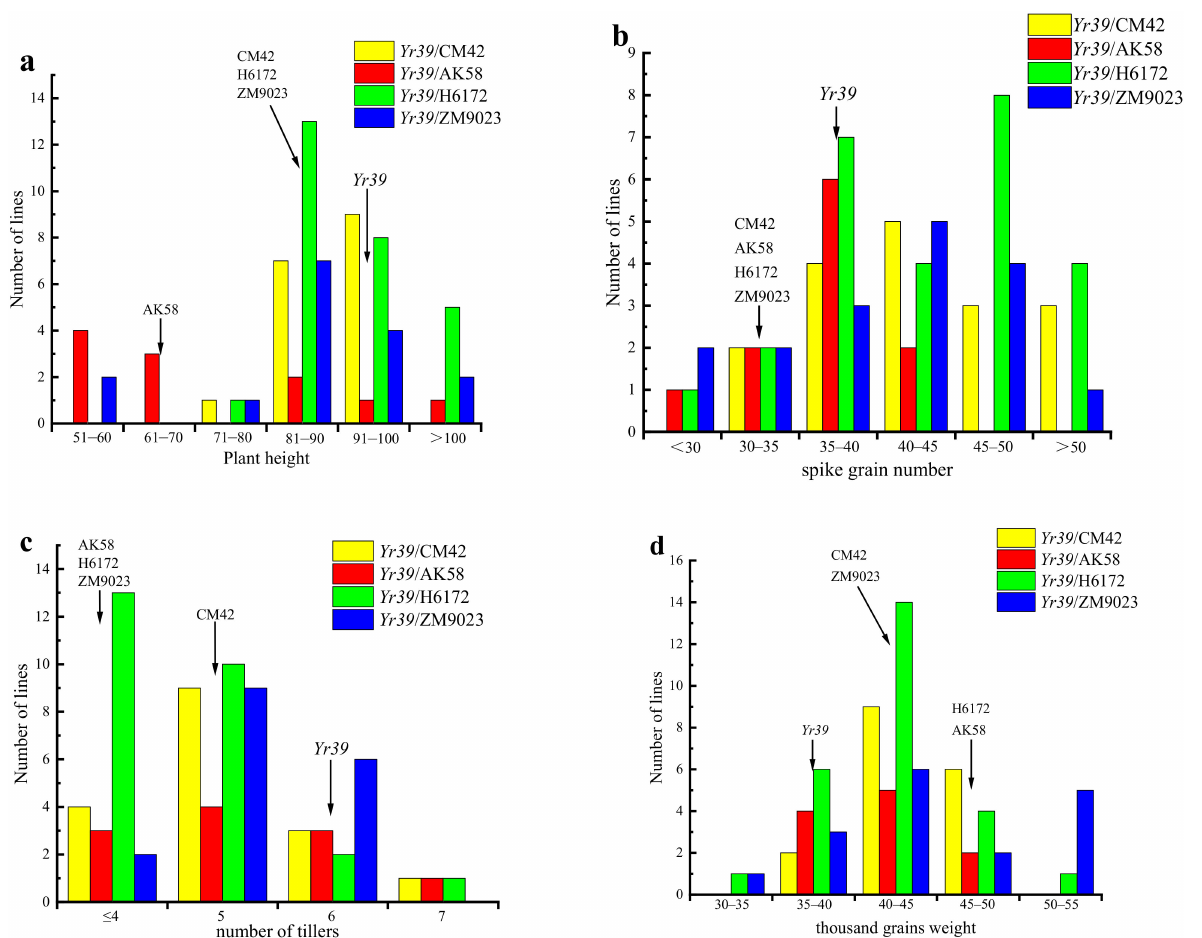
Figure 2. Frequency distribution of plant height ( a ), spike grain number ( b ), number of tillers ( c ) and thousand grains weight ( d ) for 71 backcross progeny lines in four hybrid